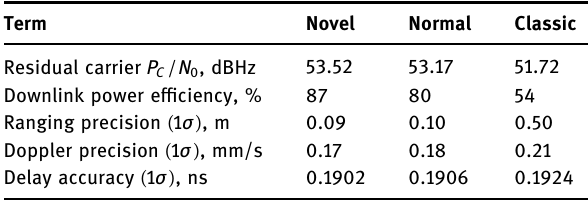
Table 3: Nominal parameter values for evaluation of delay error